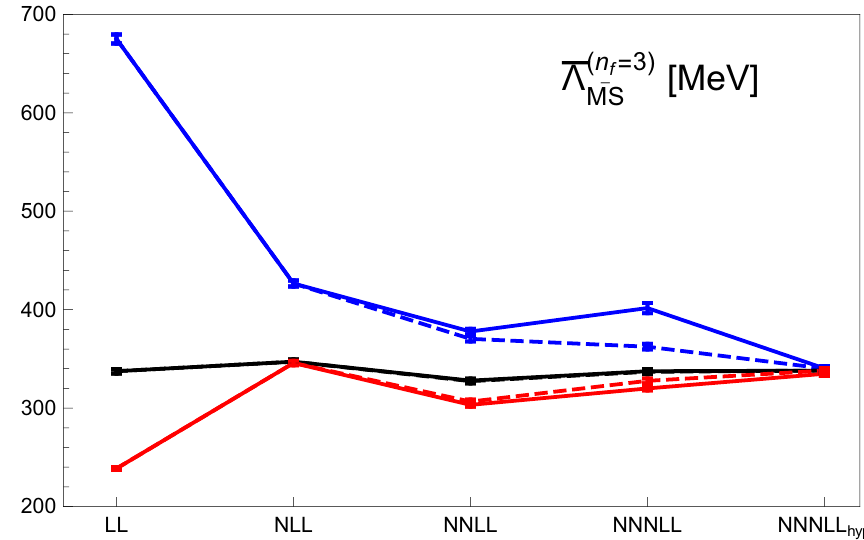
Figure 4 . Determination of (cid:3) ( n f =3) at LL, NLL, NNLL, NNNLL and NNNLL hyp using the data MS set I with (cid:23) us = C A (cid:11) ( (cid:23) s ) = (2 r ) and (cid:23) s = 2 =r (continuous blue line), (cid:23) s = 1 =r (continuous black line) p and (cid:23) s = 1 = ( 2 r ) (continuous red line). We also plot the determination of (cid:3) ( n f =3) at LL, NLL, MS NNLL, NNNLL and NNNLL hyp using the data set I with (cid:23) us = 1 GeV and (cid:23) s = 2 =r (dashed blue p line), (cid:23) s = 1 =r (dashed black line) and (cid:23) s = 1 = ( 2 r ) (dashed red line). With this scale resolution the continuous and dashed black lines are hardly distinguishable. This also happens to a large extent with the continuous and dashed red lines. The error displayed is only the statistical error of the